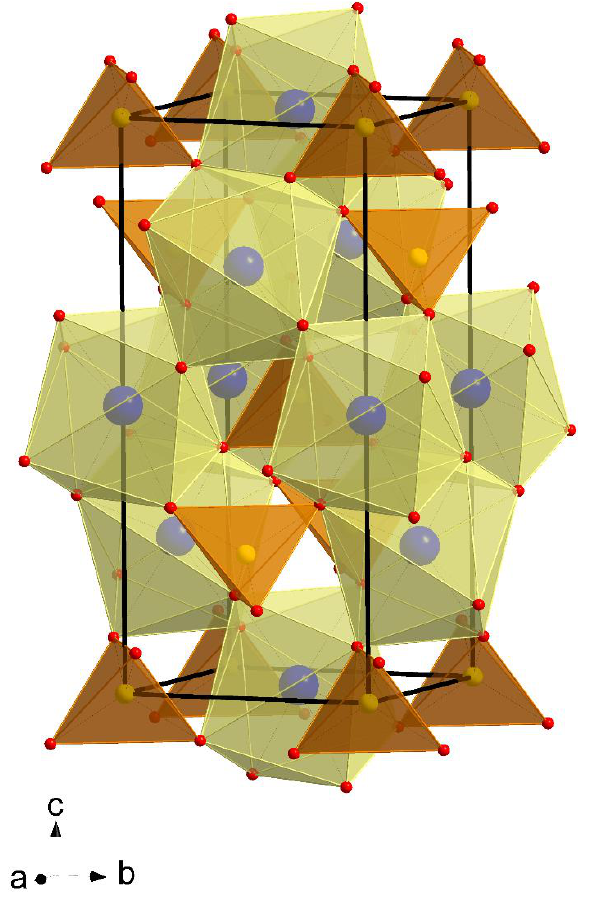
Figure 1. Structure of CaMoO 4 (Ca 2+ — blue circles; Mo 6+ — yellow circles; O 2 – — red circles).